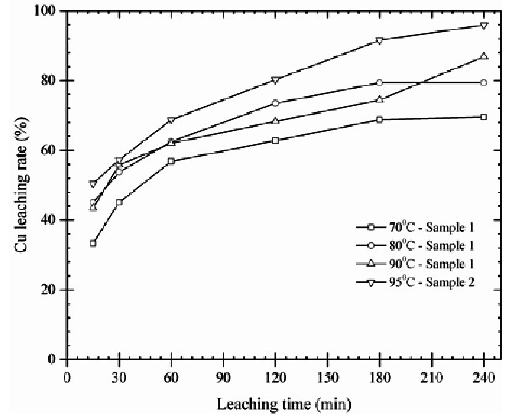
Fig. 5. Effect of temperature on copper dissolution